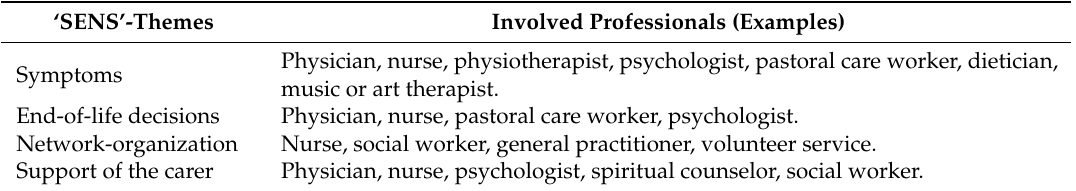
Table 4. Interprofessional team working together with the patient and family based on ‘SENS’.